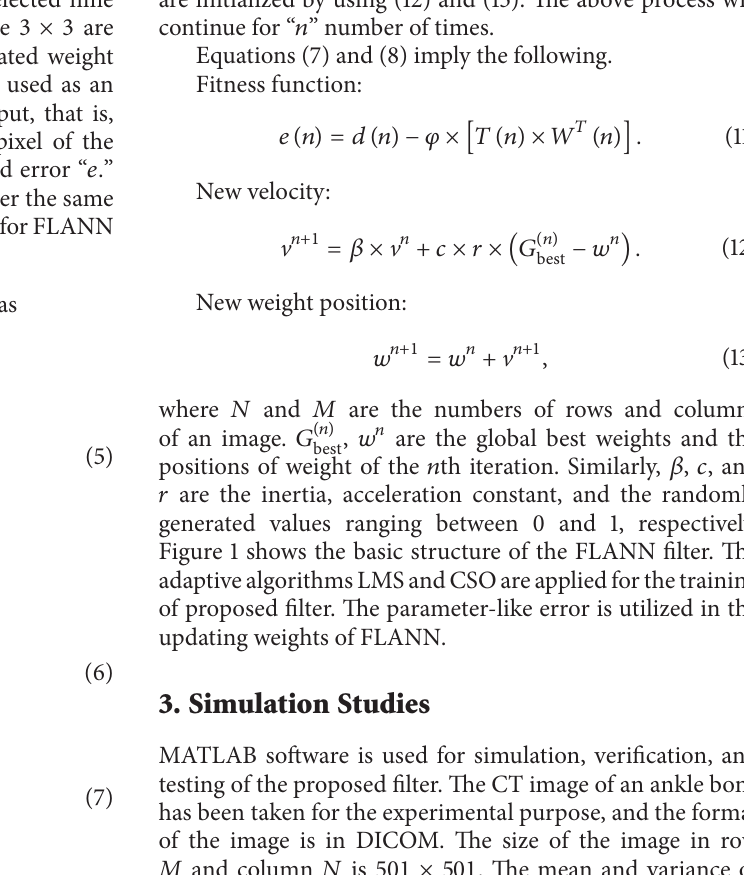
Algorithm 1. Algorithm for Cat Swarm Optimization is as